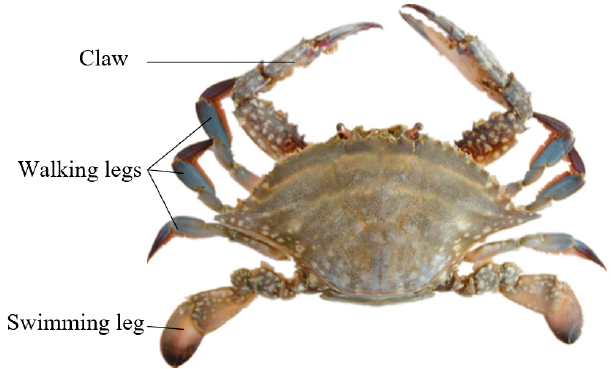
Figure 1. Structure of a crab (Portunus). Xi Chen took the figure.